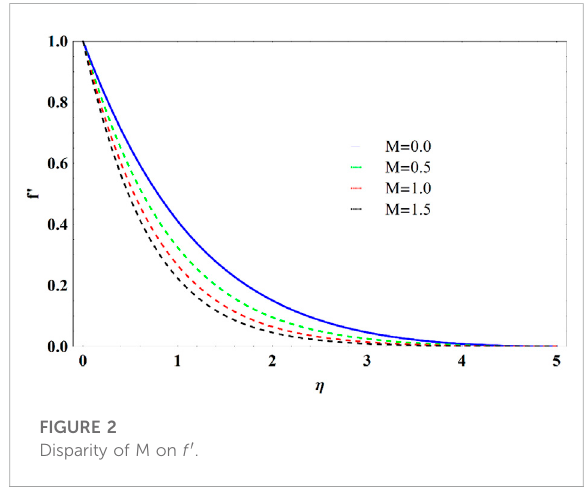
FIGURE 1 Geometry of the problem.